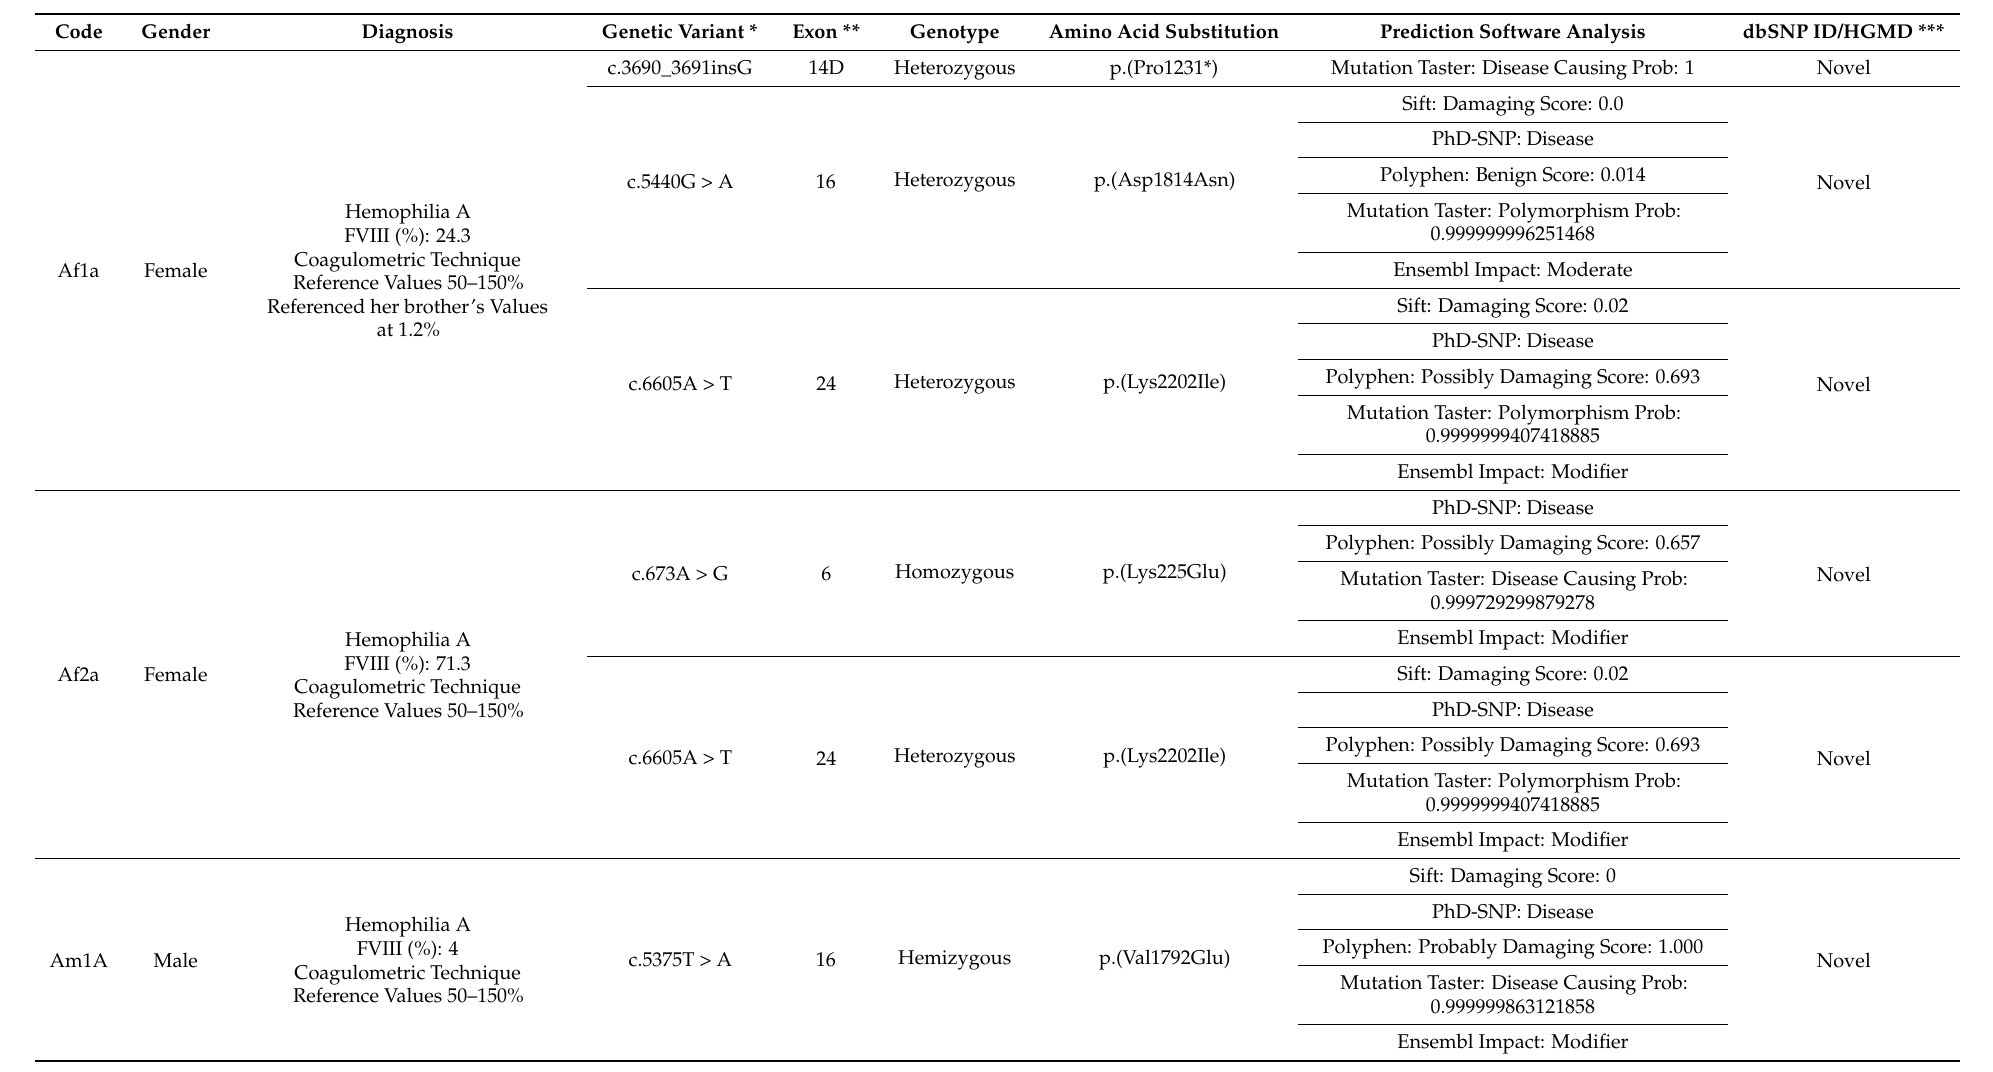
Table 2. Genotype results of patients with HA, HB, or VWD